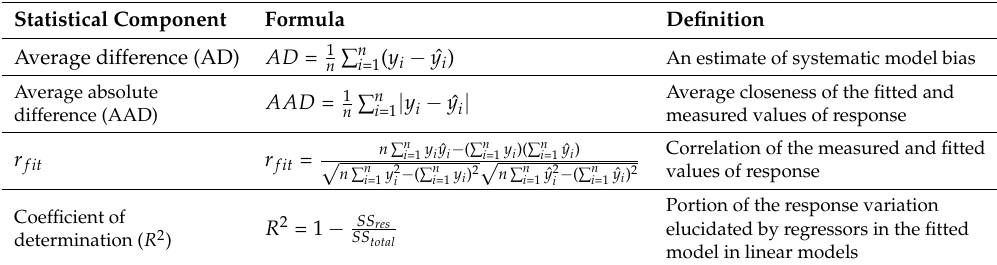
Table 5. Statistics which are used to compare model performance.